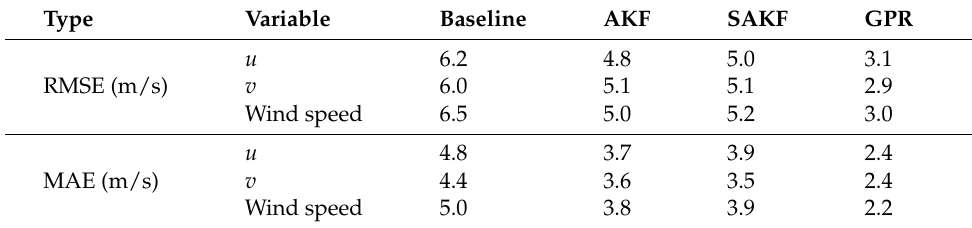
Table 1. Performance measures for the u , v